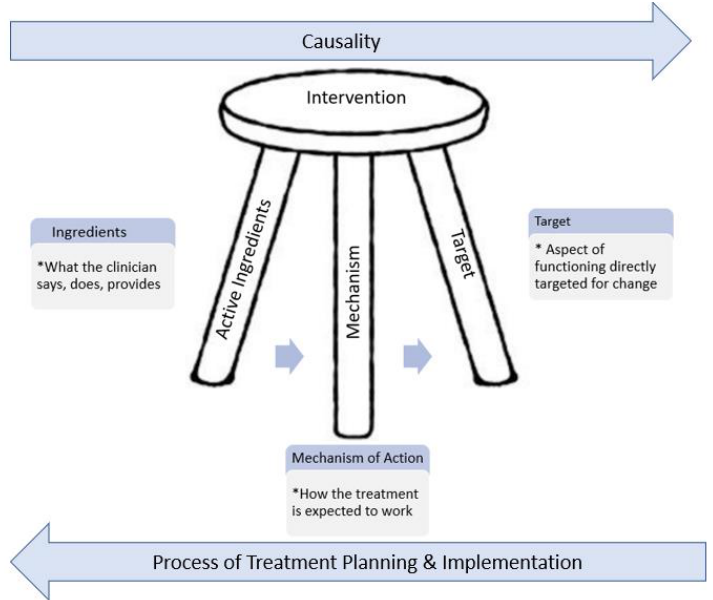
Figure 5. The Three-part structure of Intervention and Intervention Selection. Based on [83].